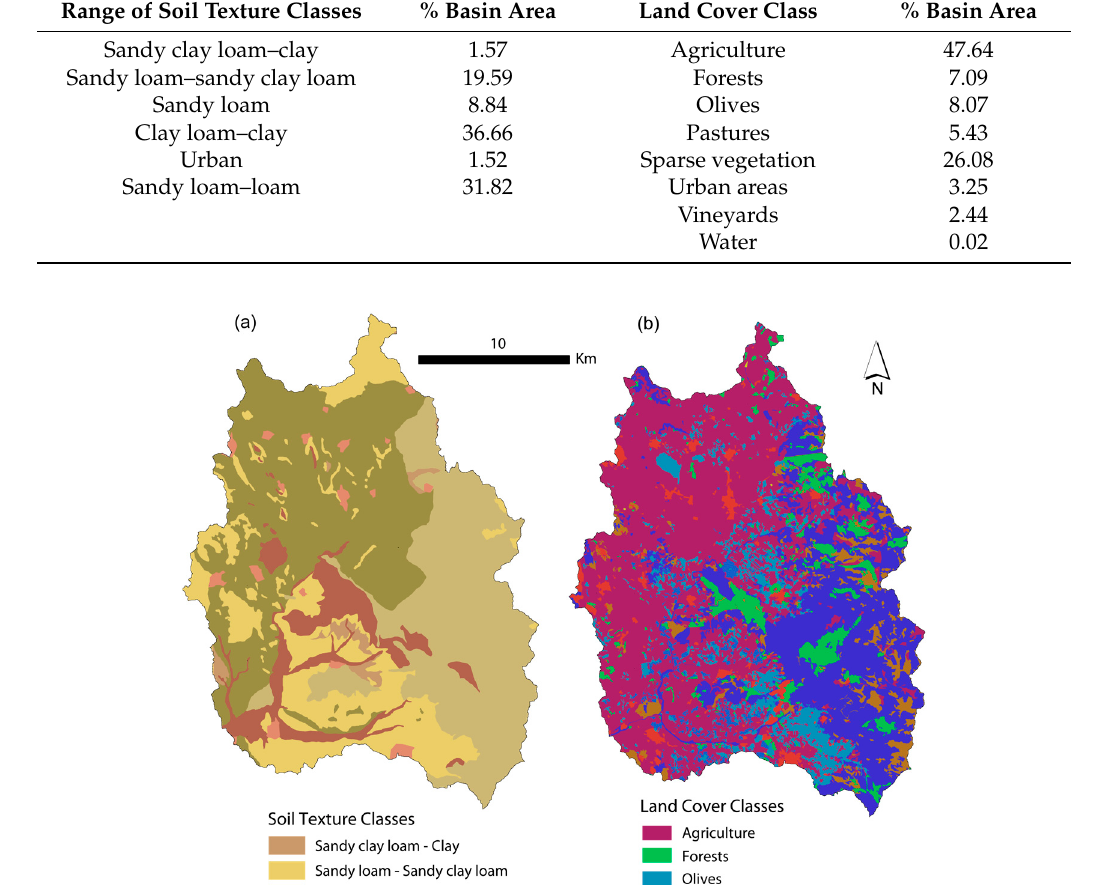
Table 1. Land cover and range of soil texture classes used as input for the three hydrologic models, with the corresponding percentage of basin area (adapted from Mascaro et al. [23]).